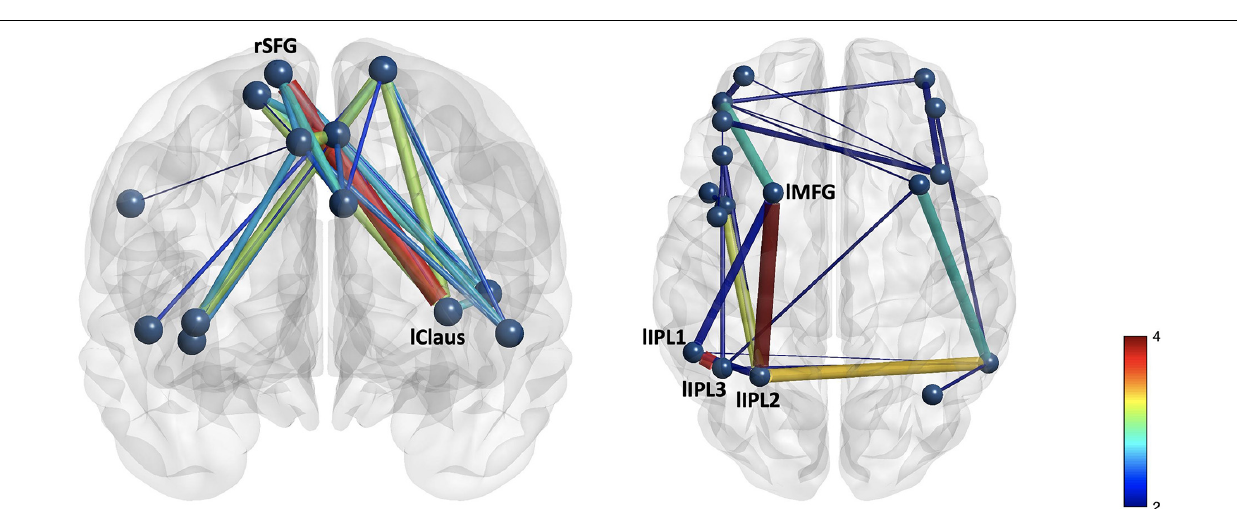
on the right (effort effect) and left (TOT effect) ( Figures 3 , 5